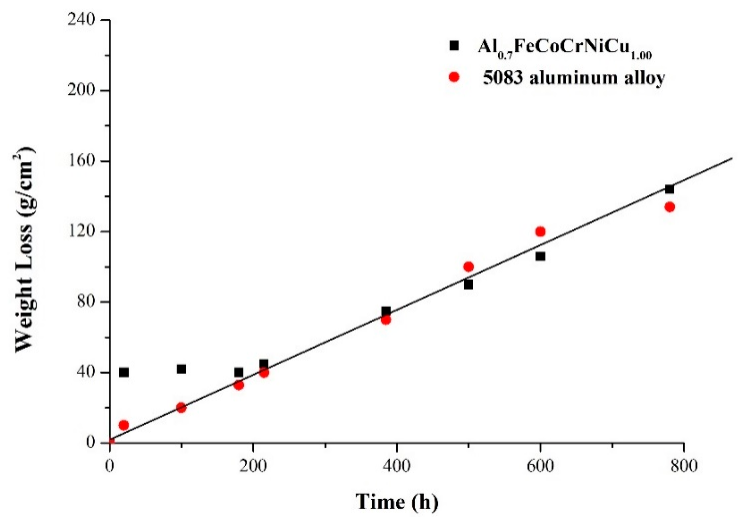
Figure 9. The weight loss varies with time.